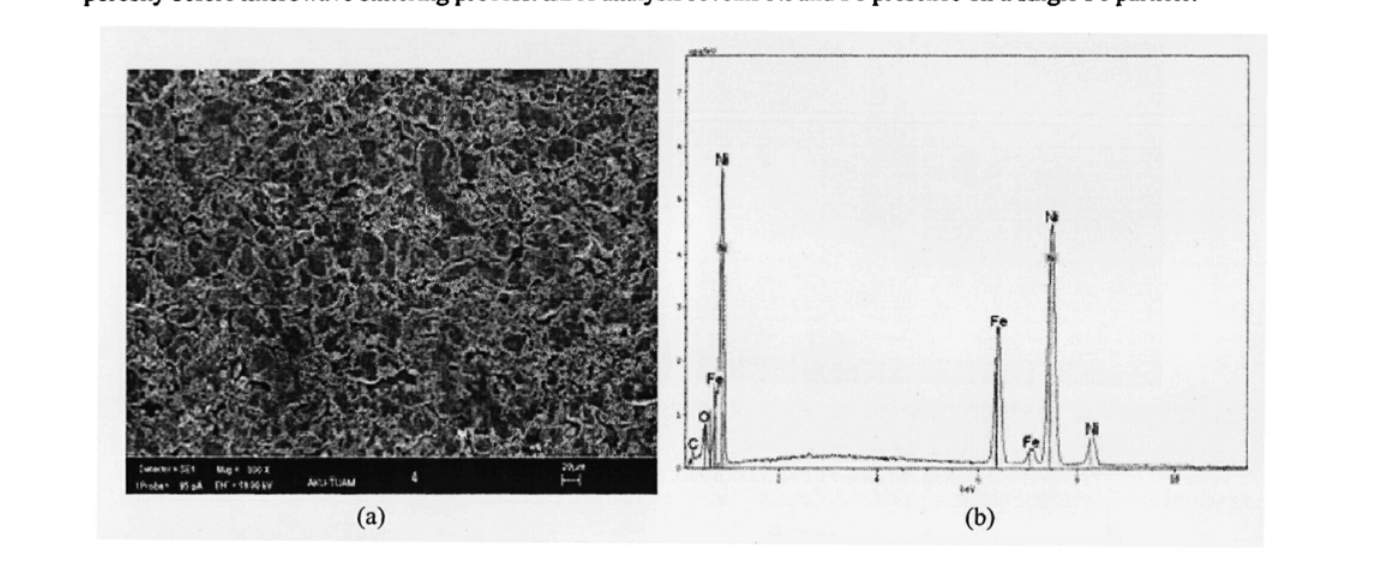
Fig. 4: An SEM image and EDX analysis from (WC+Fe)Ni specimen (a) an SEM image showing the surface of the compact (b) EDX analysis of the surface shown in